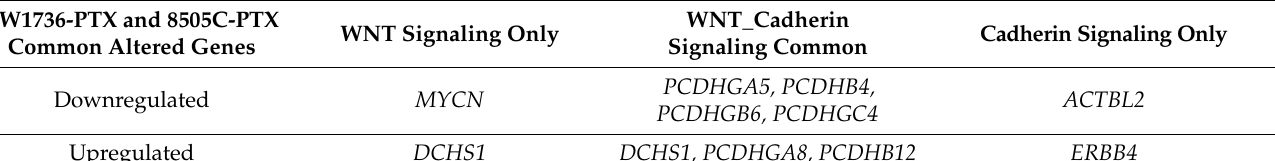
Table 1. List of genes commonly up- or downregulated in SW1736-PTX and 8505C-PTX after GSK2801 treatment and involved in WNT signaling pathway, cadherin signaling pathway, or both.